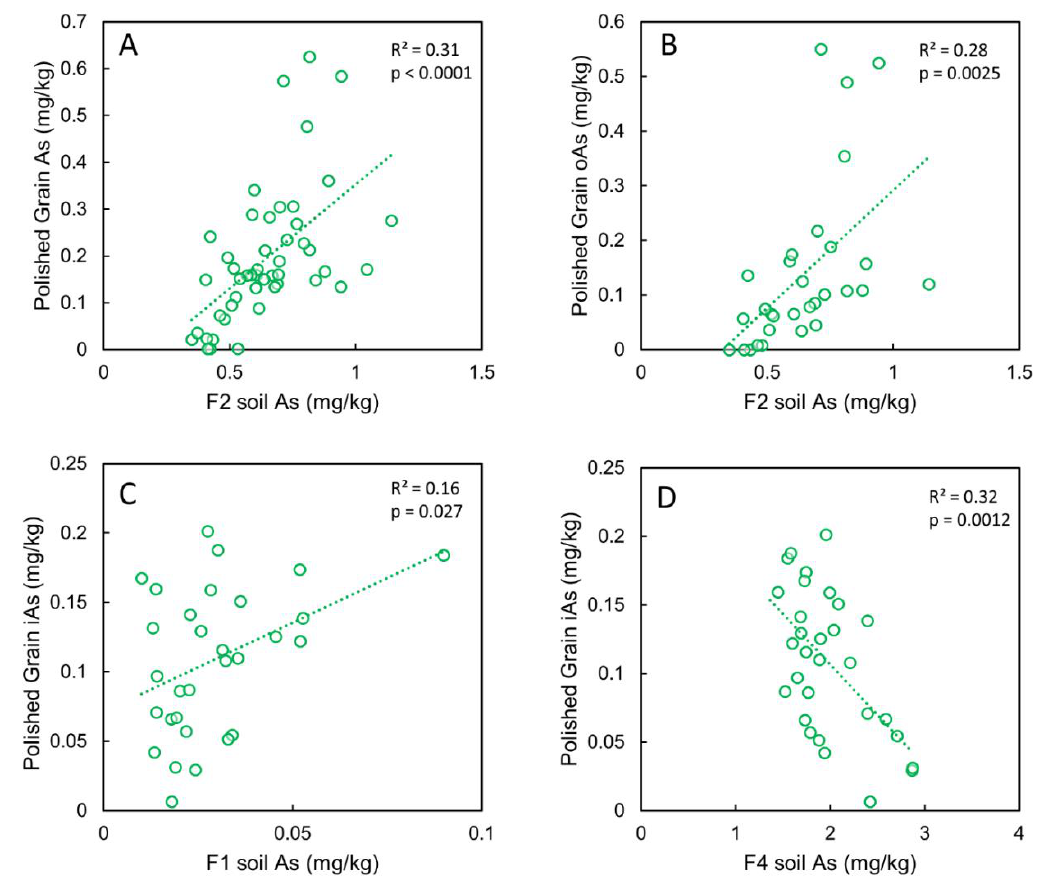
Figure 10. Relations between plant-available soil As pools and ( A ) total or ( B – D ) speciated grain As in the field